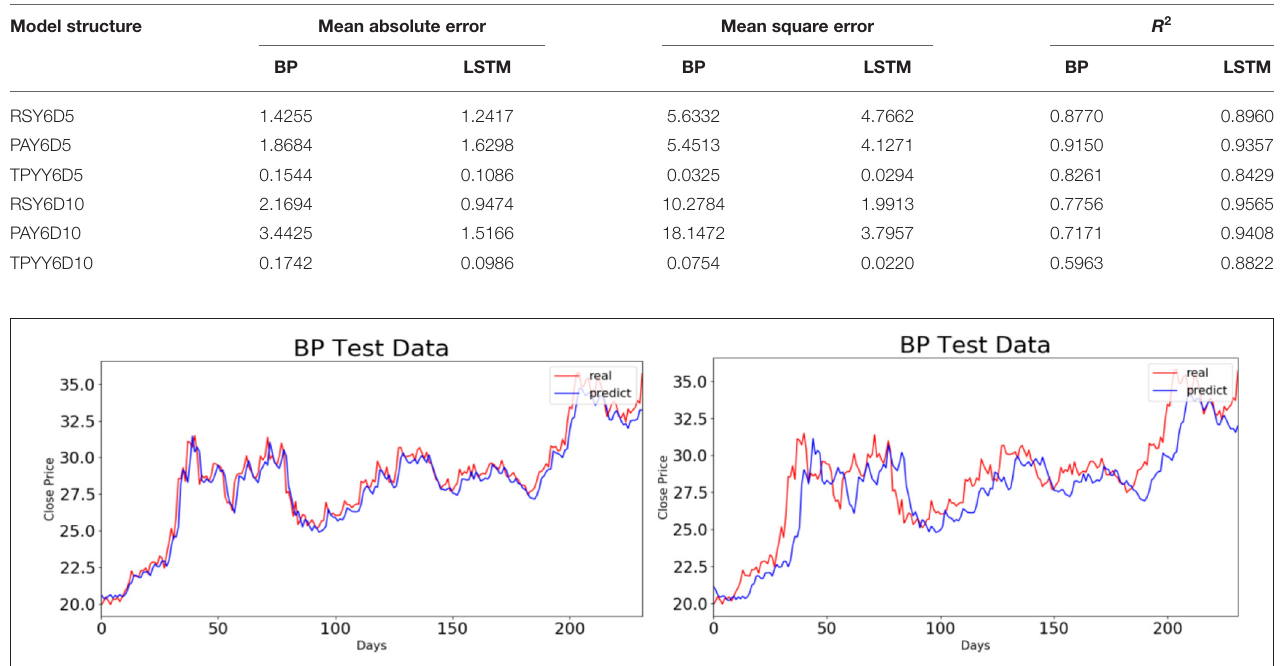
FIGURE 6 | Fitting effect diagrams of back propagation neural network model in two test sets.